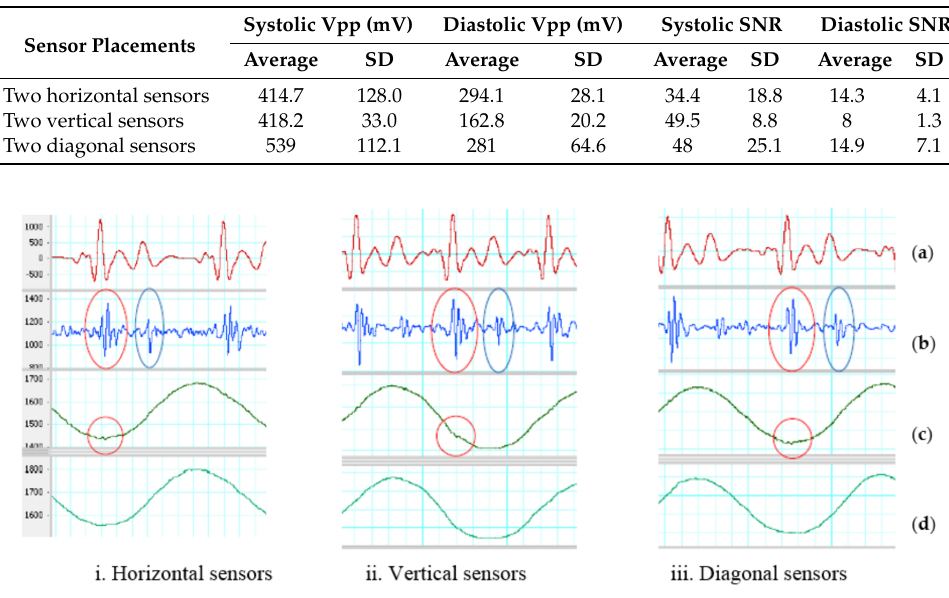
Figure 6. SUBTRACTOR on gentle movement. ( a ) Filtered ECG (5–20 Hz). ( b ) Filtered SCG (20–50 Hz). Red oval indicates an identified systolic. Blue oval indicates a recognized diastolic. ( c ) First sensor z-axis. Red circle indicates a small SCG signal. ( d ) Second sensor